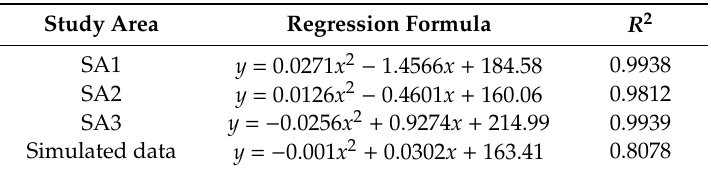
Table 9. Functional relationship between the slope RMSE ( y ) and the number of points in the neighbourhood ( x ) in study areas 1–3 and simulated data.